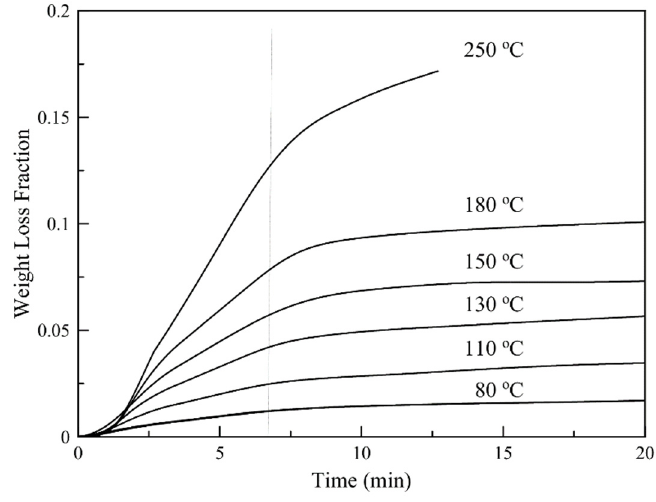
Figure 9. Isothermal TGA thermographs for different temperatures.